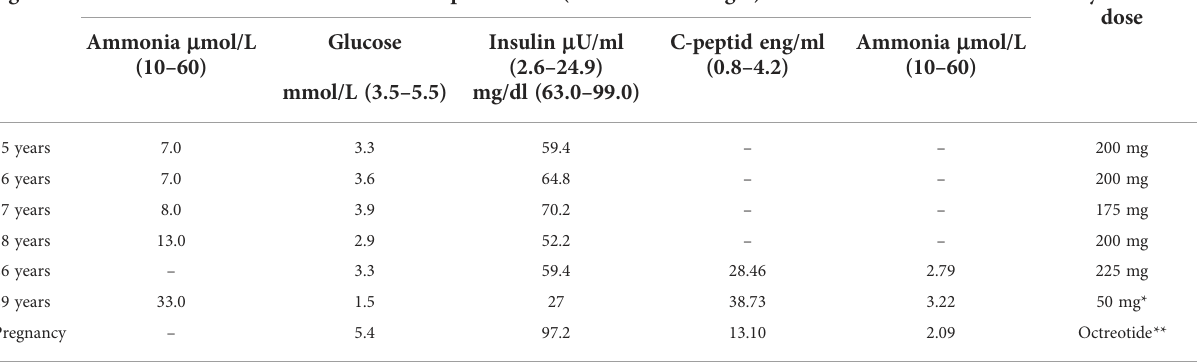
TABLE 1 Serum levels of ammonia, glucose, insulin, and C-peptide at various ages and daily dose of diazoxide therapy. Age Metabolic parameters (with normal